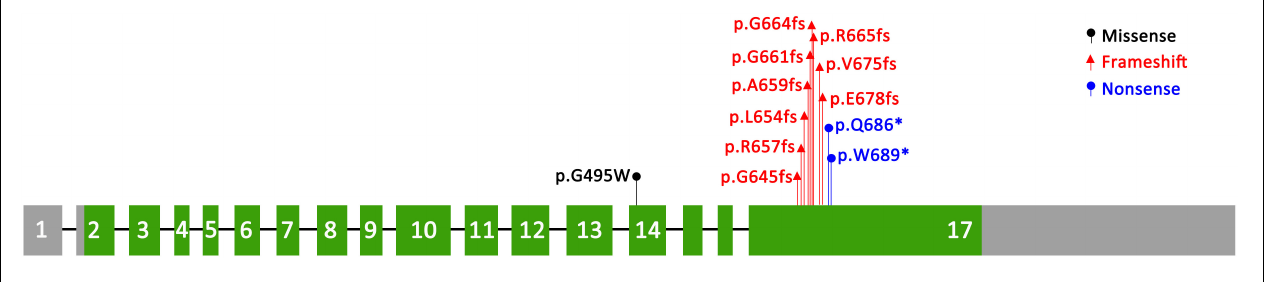
FIGURE 3 | Distribution of known variants in